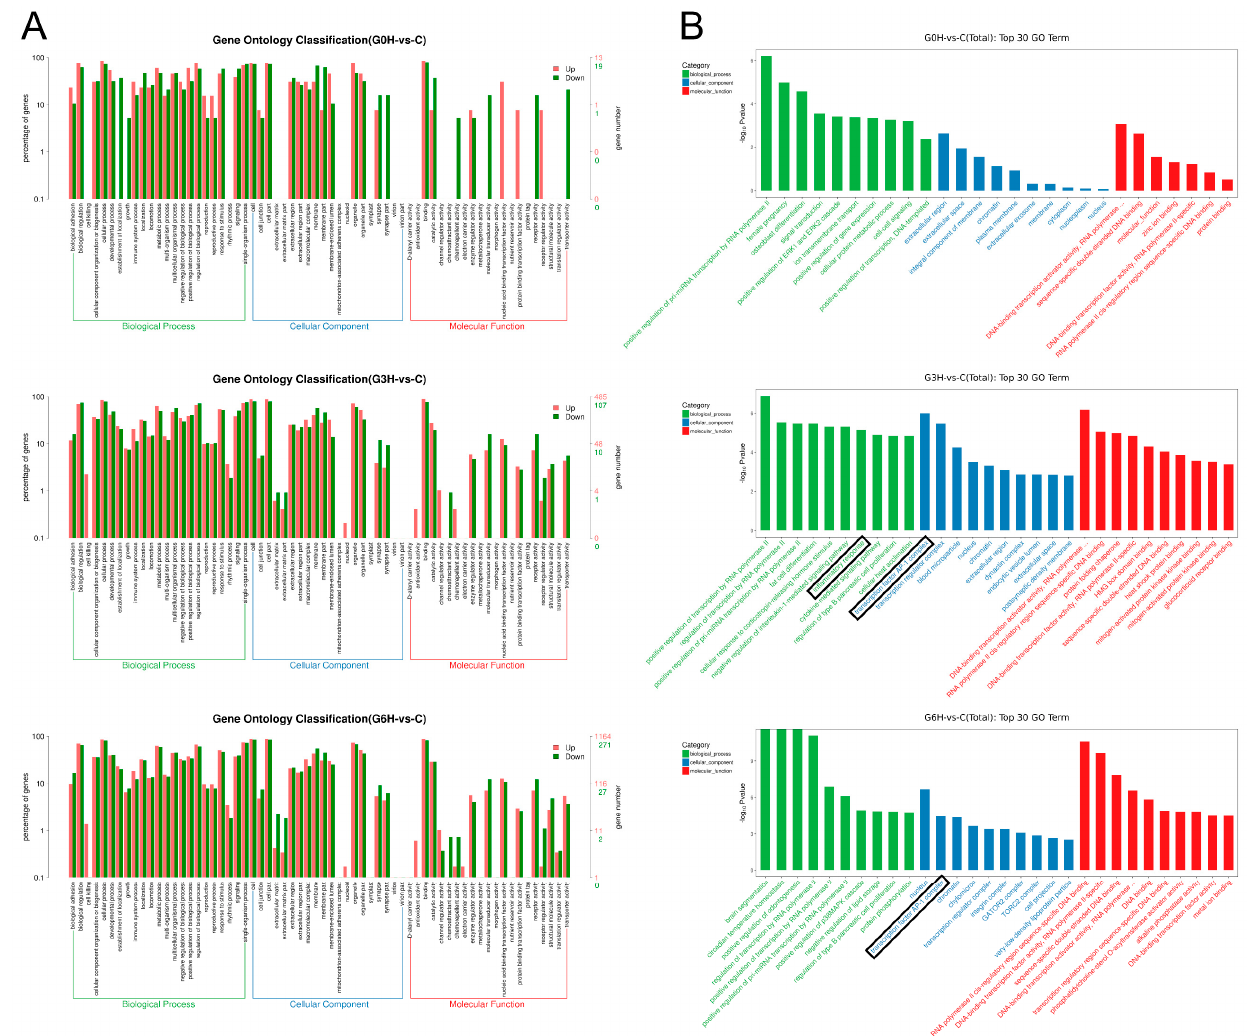
Figure 3. Data mining of the time series transcriptomic changes of electroporation-induced apoptosis. ( A ) Gene ontology (GO) term analysis was performed to annotate the up- and downregulated differential expression genes into 64 groups based on the GO level2 entries classifications. (B) GO terms were sorted by the -log10P-value, and the top 10 GO terms in each of the three GO level1 categories were displayed. The term "transcription factor AP-1 complex” of “cellular component" and “inflammatory response” of “biological process” was depicted by a black rectangle.